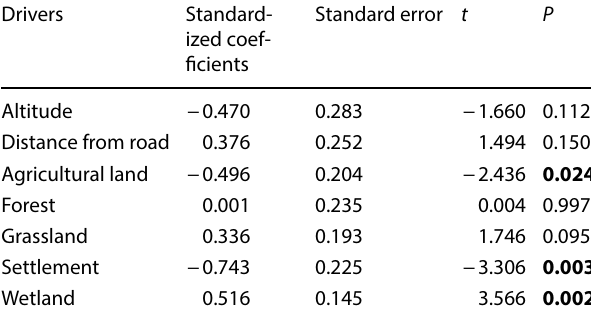
Table 2 The effect of land-use and environmental factors outputs from generalized linear models with Poisson distribution on the species richness in the FFL of the Southern Rift Valley, Ethiopia